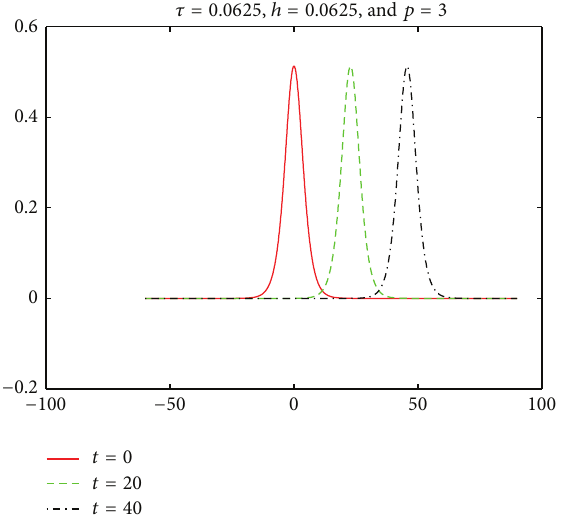
Figure 2: Wave graph of 𝑢 (𝑥,𝑡) at various times when 𝑝 = 3 and 𝜏 = ℎ = 0.0625 .